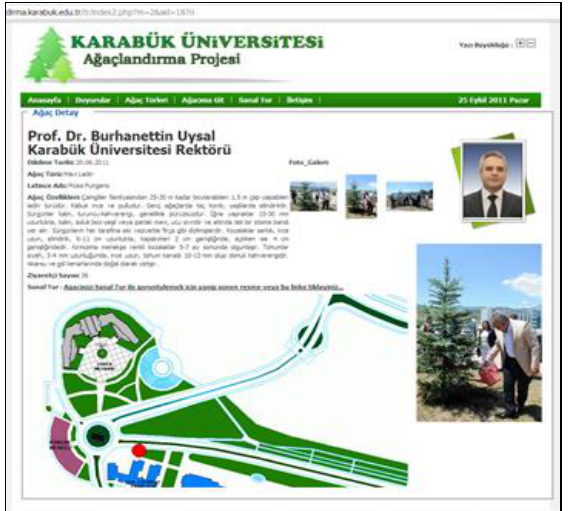
Figure 17. Tree Information System of Karabuk